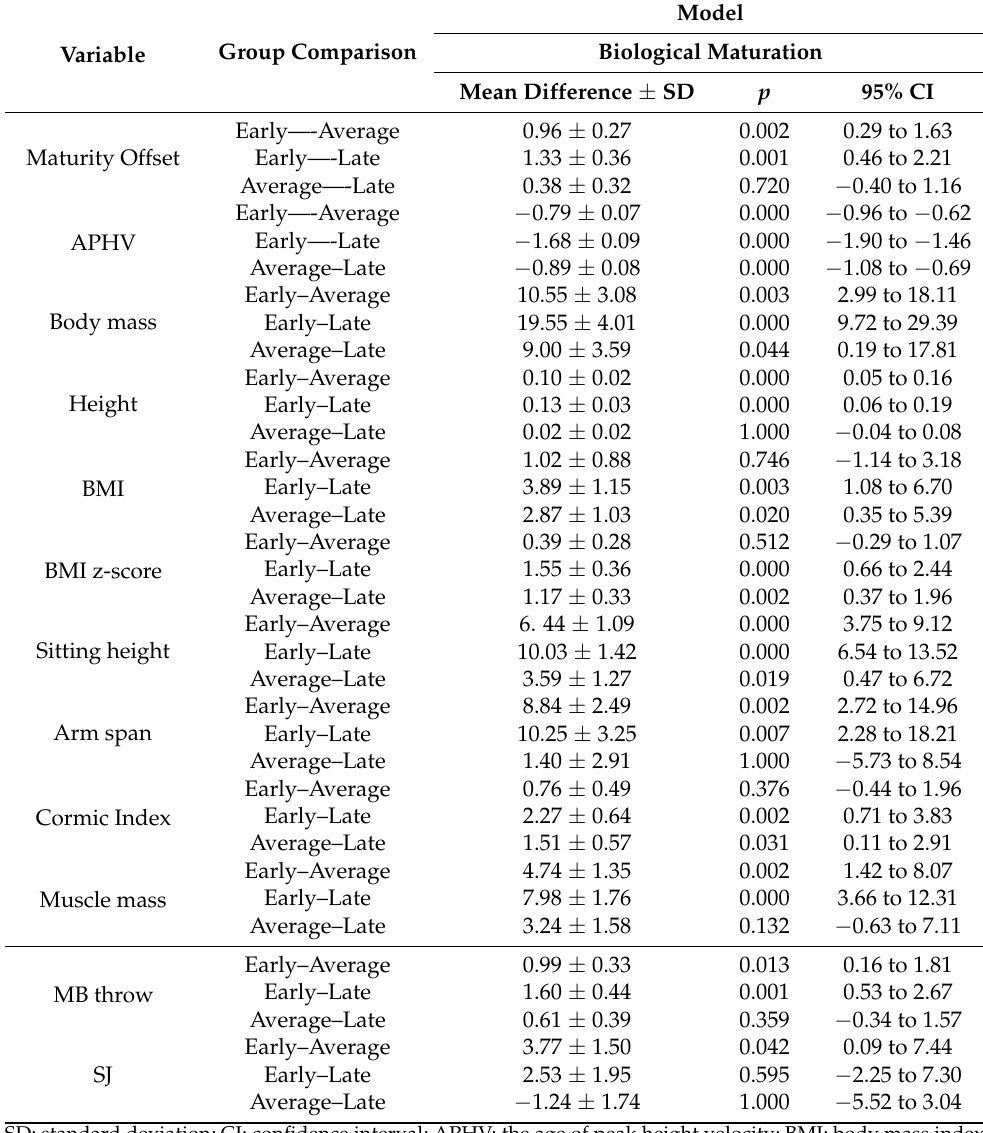
Table 2. Post hoc comparison between biological maturation groups after ANOVA analysis for kinanthropometric characteristics and physical test